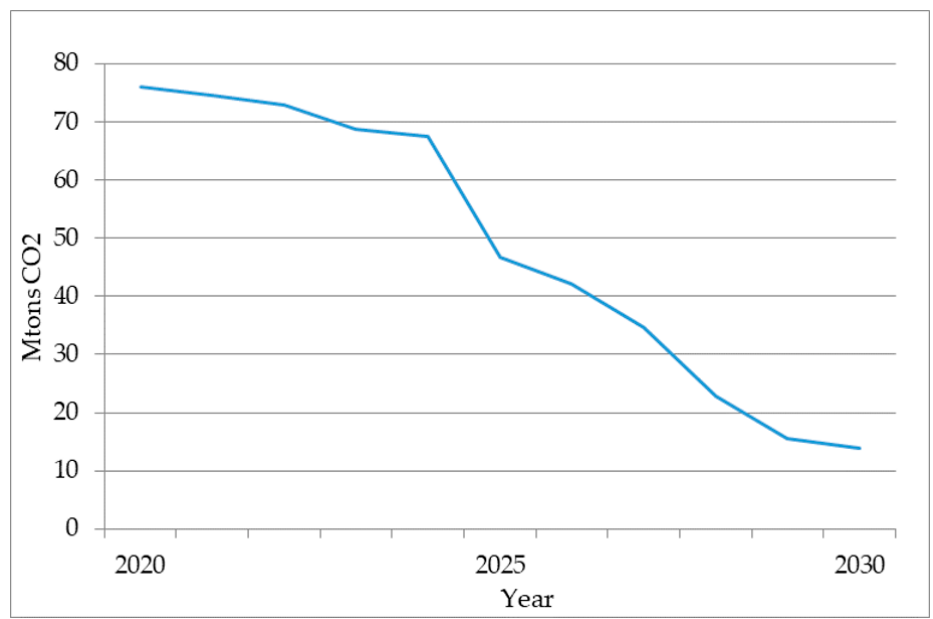
Figure 24. CO 2 emissions in the MAXRES scenario. Source: own elaboration with the model.